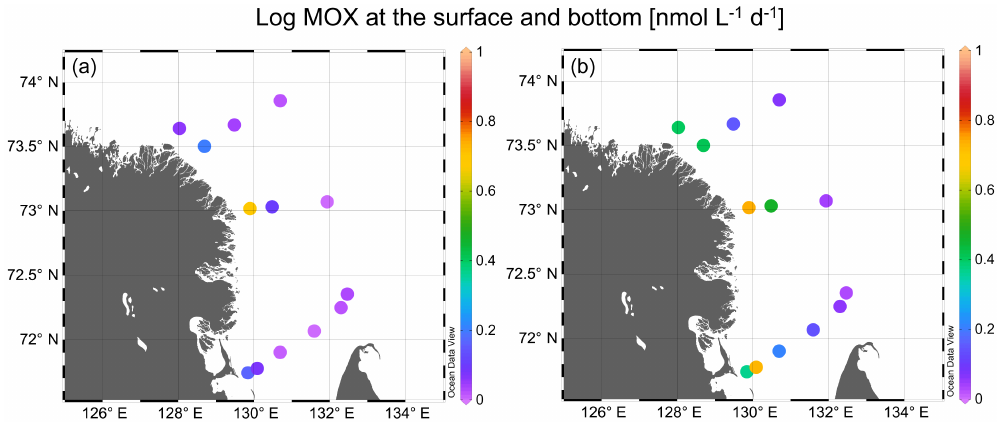
Figure 5. Logarithm of the methane oxidation rates in nmolL − 1 d − 1 in surface (a) and bottom (b) water around the Lena Delta. Table 3. Linear correlation between the methane oxidation rate (MOX) and the fractional turnover rate ( k (cid:48) ) vs. different environmental parameters separated for the three water masses. Analysis was performed with log-transformed data; the r 2 values, the level of significance ( p ), and the positive or negative correlation ( + / − ) are shown. Bold numbers indicate a significant correlation ( p < 0 . 05). Riverine water Mixed water Polar